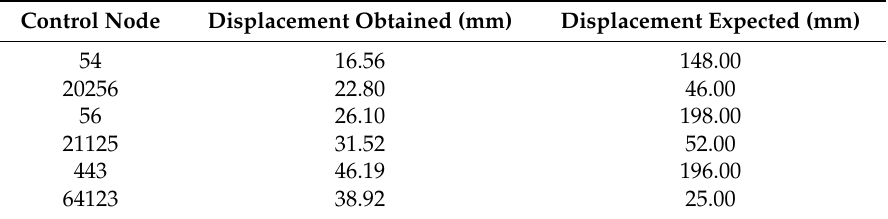
Table 7. Comparison between expected and predicted displacement of the considered control nodes.